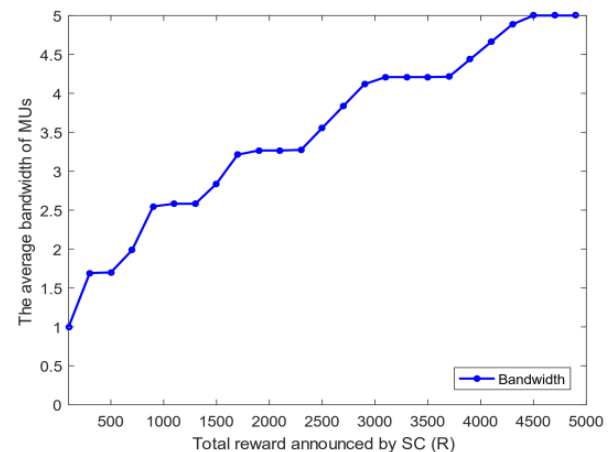
Figure 8. Average bandwidth selected by MUs when R changes.